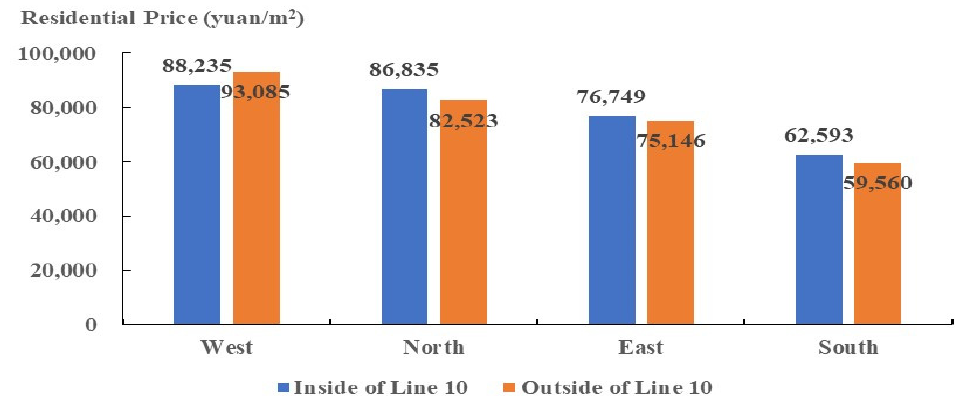
each area along Metro Line 13.